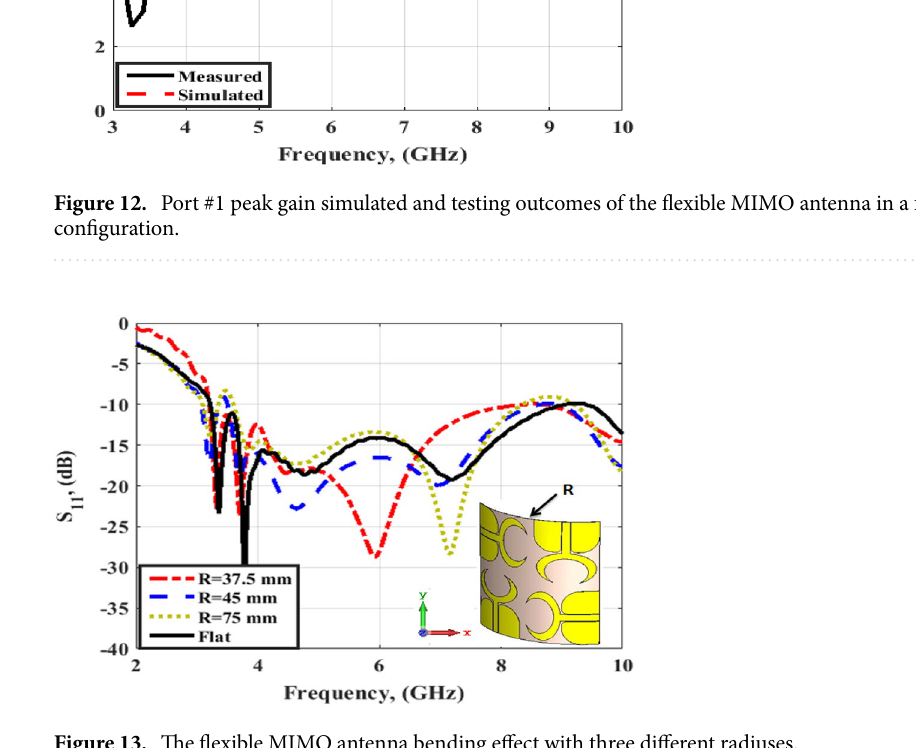
Figure 13. The flexible MIMO antenna bending effect with three different radiuses.